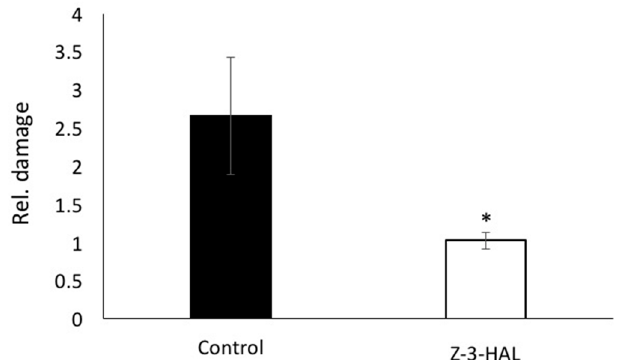
Figure 4. The effect of in-cold ( Z )-3-hexen-1-al (Z-3-HAL) treatment on damage in maize ( Zea mays ) seedlings. Assessment of damage on a scale from 0 (no damage) to 4 (dead). The values are means ± SD, and the asterisks indicate significant differences between the treated and untreated seedlings (Students t -test, p < 0.05).